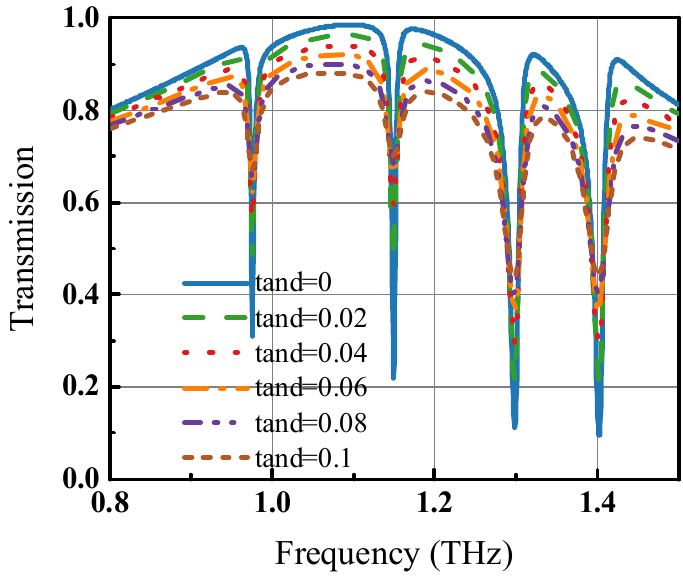
Figure 7. Transmission spectrum of the sensor at various values of tan δ of the analyte.